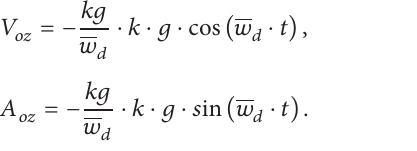
It can be inferred that phase of displacement of heaving motion was inverted to acceleration and the amplitude was proportional to frequency squared. The parameter 𝑘 was proposed to describe the strength of heaving motion. Figure 8 plotted the flux of natural circulation, conden- sate depression of heating section’s outlet, and the secondary side of heat exchanger under heaving motion with